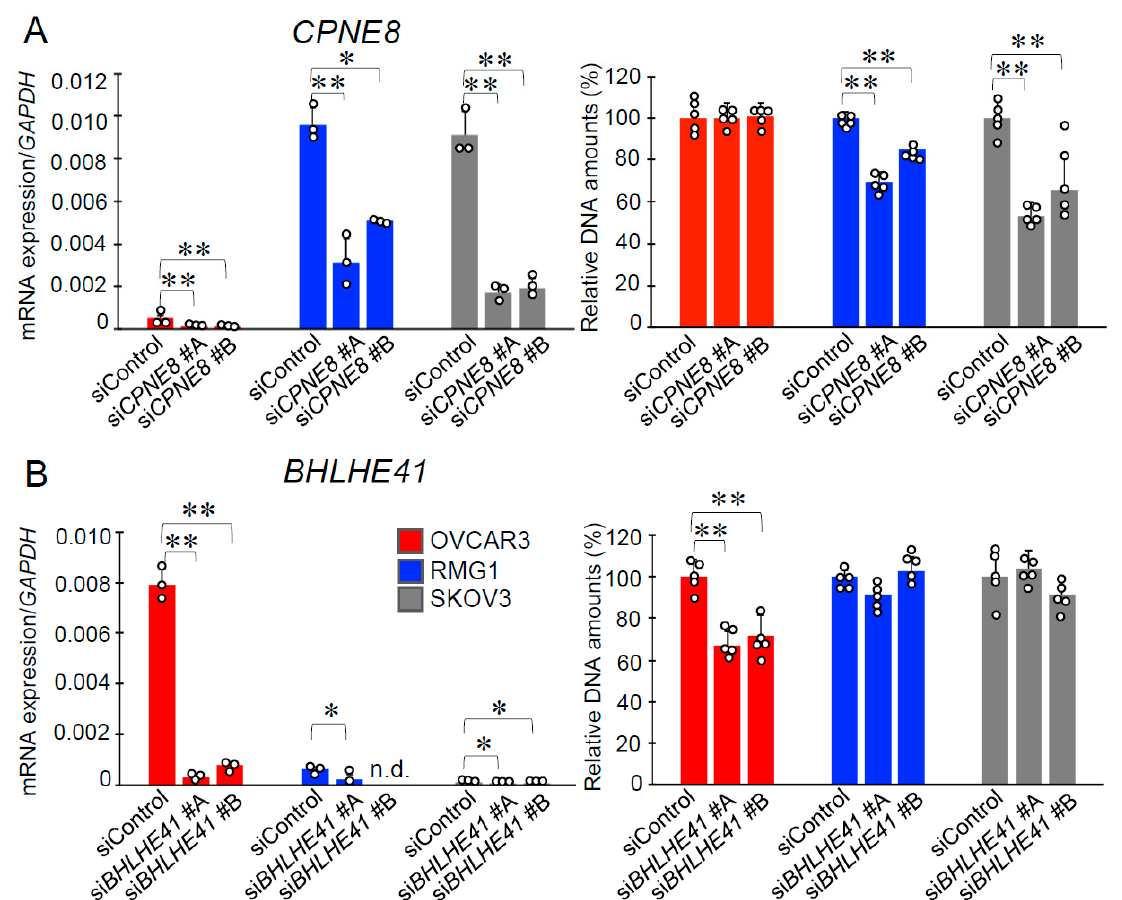
Figure 4. Growth inhibitory effects of siRNAs targeting CPNE8 and BHLHE41 in ovarian cancer cells. ( A ) The knockdown efficiency of CPNE8- specific siRNAs (si CPNE8 #A and #B) was examined in OVCAR3, RMG1 and, SKOV3 cells ( n = 3, left panel). A DNA assay was performed to assess cell growth 4 days after si CPNE8 #A, #B, or control siRNA (siControl) transfection ( n = 5, right panel). ( B ) The knockdown efficiency of BHLHE41- specific siRNAs (si BHLHE41 #A and #B) ( n = 3, left panel) and its effect on cell growth ( n = 5, right panel) were examined as in (A). Row data are indicated by circles. Results are shown as means ± SD; *, p < 0.05; **, p < 0.01, using one-way ANOVA with Tukey’s HSD test; n.d., not detected.